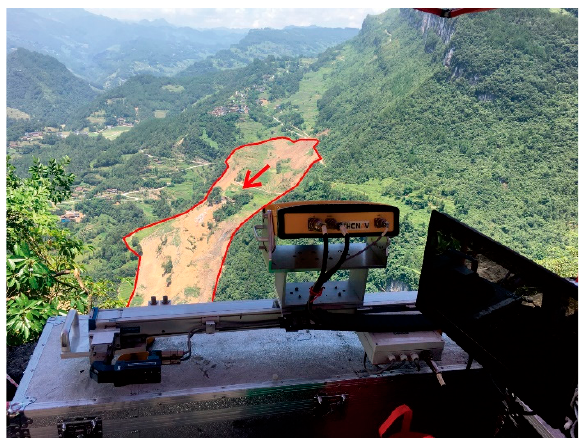
Figure 3. GB-InSAR system employed in the emergency monitoring.